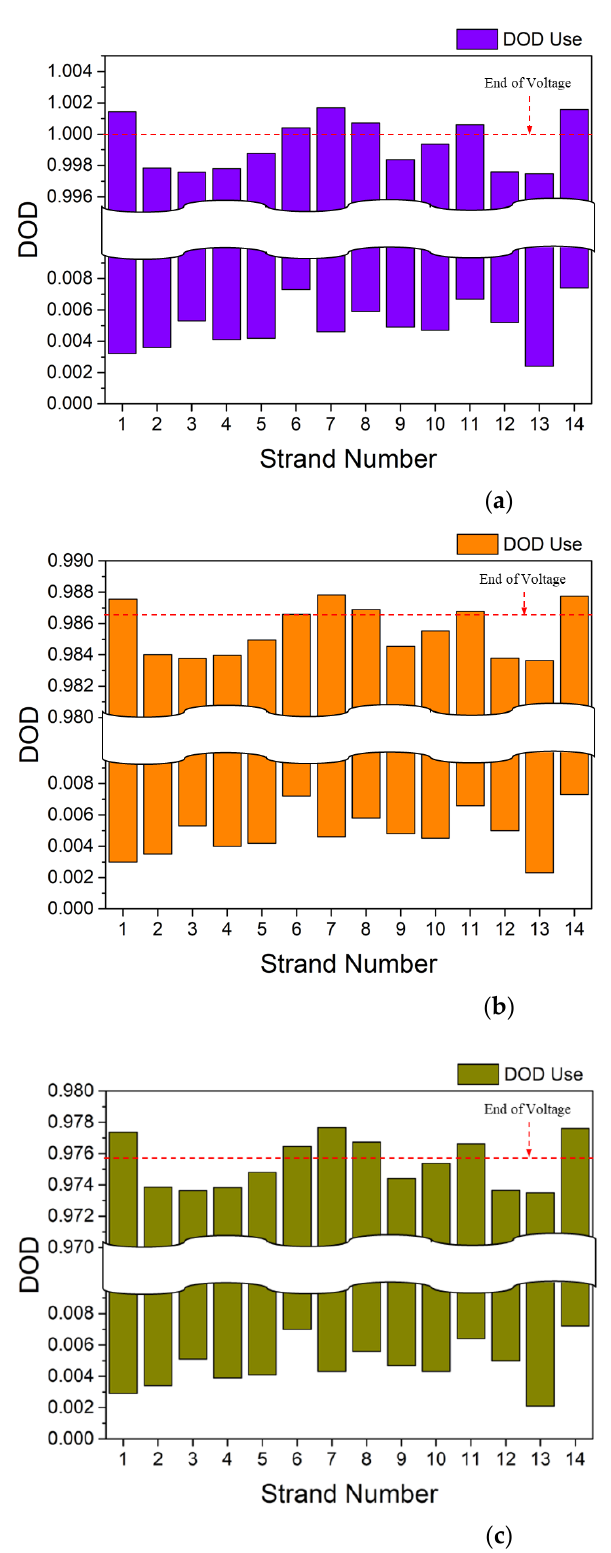
Figure 12. Modeling results of DOD use distribution of LIB strands during discharge ( a ) 0.2 C, ( b ) 0.5 C, and ( c ) 1 C. ( b ) 0.5 C, and ( c ) 1